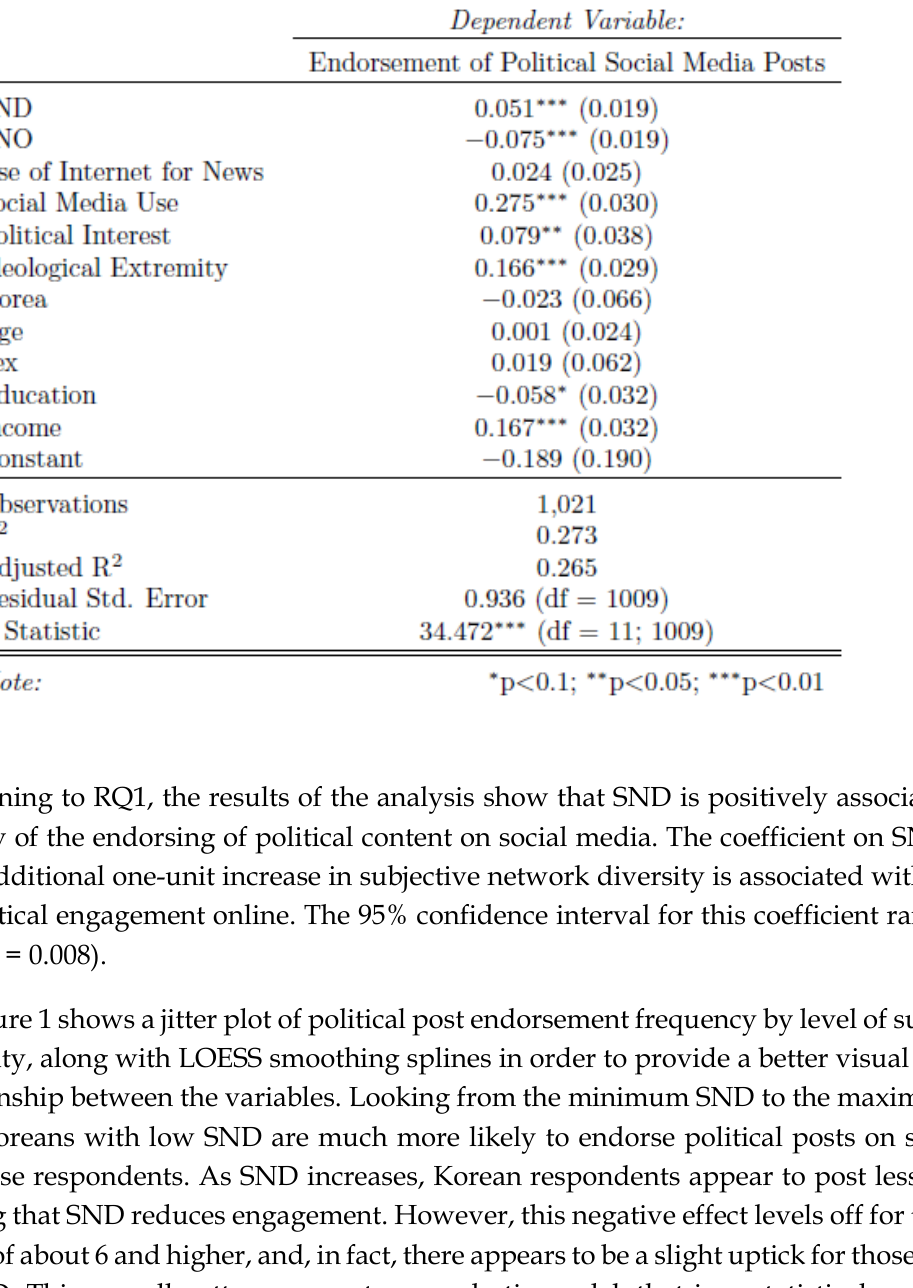
Table 2. The Relationship between SNO, SND, and Endorsing Behavior (Pooled